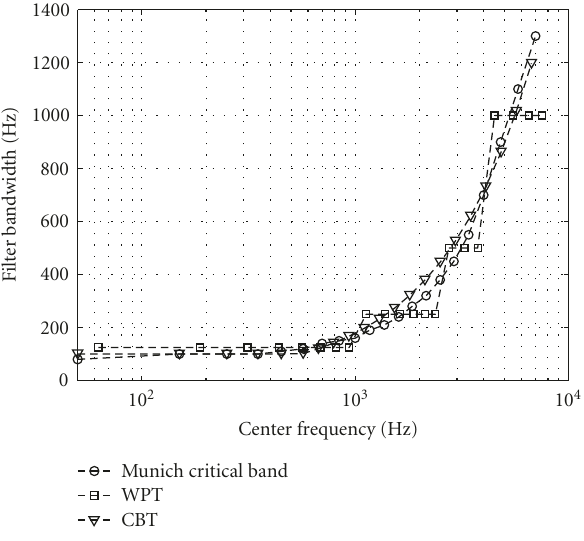
Figure 1: Degree of approximation to Munich Bark critical